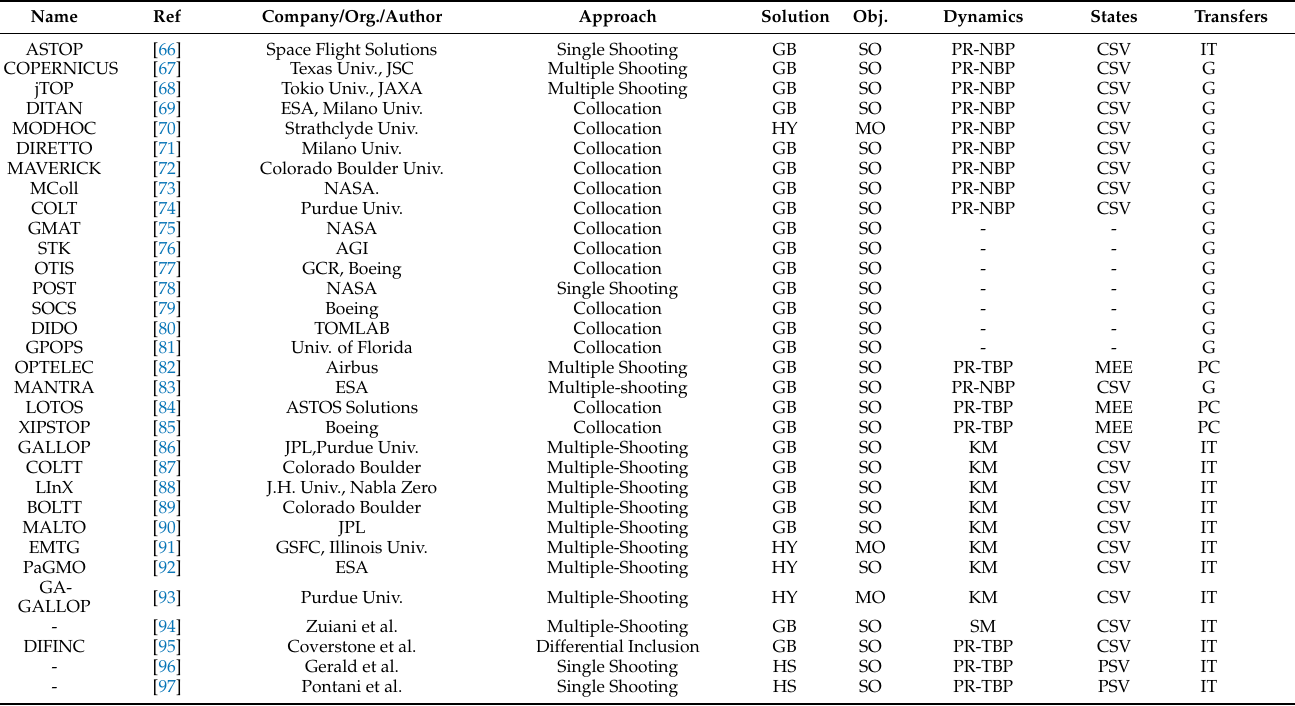
Table 2. Representative Tools Implementing Direct Methods for Low-Thrust Trajectory Optimization.